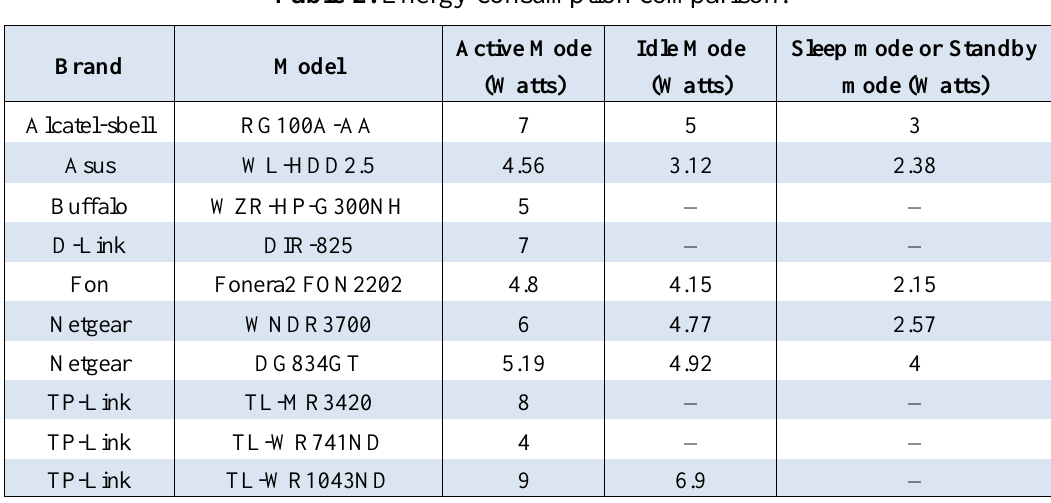
Table 2. Energy consumption comparison.